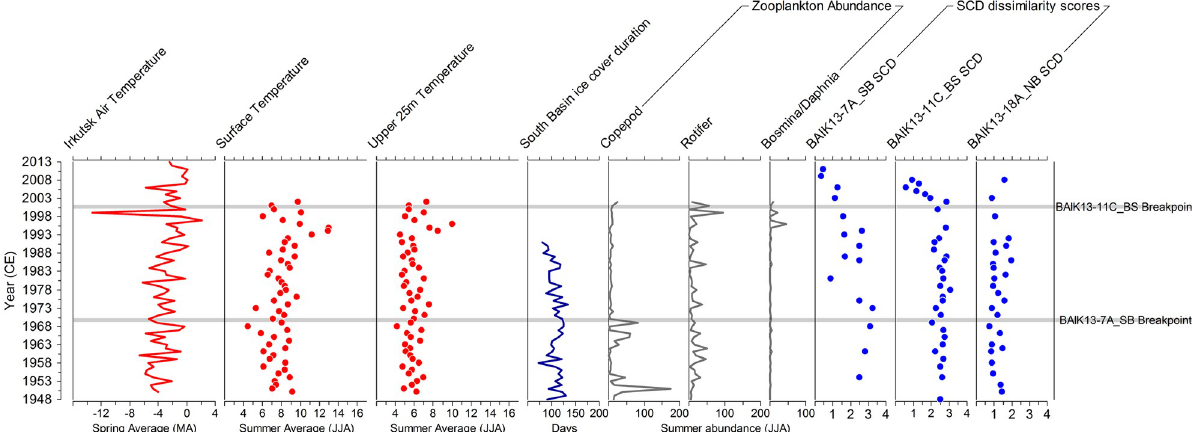
Fig 7. Regional spring Irkutsk air temperatures (March and April average) from a climate station next to the south basin of Lake Baikal (World Meteorological Organisation station 30710; 52˚16’20”N, 104˚18’29”E; elevation = 467 m) are shown over the period 1950 CE to 2013 CE. Summer surface water temperatures and water temperatures in the upper 25m of the water column (July to August average) are shown for the south basin over the period 1948 CE to 2002 CE [9]. Ice cover duration data for the south basin of Lake Baikal is shown between the period 1869 CE to 1996 CE [25]. Zooplankton summer abundance (1000 cells L -1 ) for copepods, rotifers and Bosmina / Daphnia are shown for the period 1950 CE to 2002 CE (data provided by S. Hampton). The stratigraphic plot includes SCD dissimilarity scores, comparing upper core top samples to all samples below in the same core. Timings of significant breakpoints in the SCD scores are also highlighted in grey for BAIK13-7A_SB and BAIK13-11C_BS diatom assemblages. No significant breakpoints were found in the BAIK13-18A_NB diatom assemblage data. [SB: South basin, BS: Buguldieka Saddle and NB: North basin].